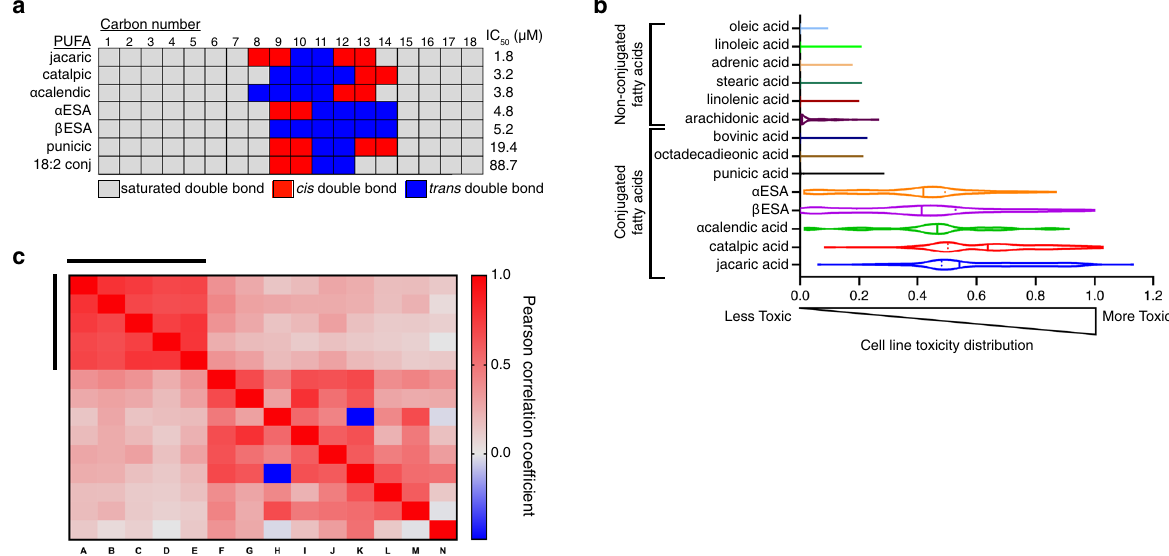
Fig. 3 Conjugated linolenic fatty acids are generally toxic to diverse cancer cells. a Schematic representing the location and double bond geometry of 18- carbon conjugated polyunsaturated fatty acids. Cell viability IC 50 values are shown for each conjugated PUFA from at least two biological replicate measurements in MDA-MB-231 cells after 72 h of treatment. b Assessment of fatty acid toxicity across cancer cell lines. A mixture of 100 barcoded human cancer cell lines were treated in triplicate with the indicated fatty acid at doses from 0 – 35 µ M. Viable cells of each cell line in the mixture were quanti fi ed at 48 h of treatment. A violin plot illustrates the distribution of cell line-speci fi c toxicities (calculated as the area over the dose dependent-cell viability curve across the treatment dose range). A toxicity value of 1 denotes complete loss of viable cells and 0 corresponds to viability similar to vehicle-treated controls. Dark bars denote median toxicity against all cell lines in the panel and dotted lines indicate quartile boundaries. c Heatmap presenting the Pearson correlation coef fi cients of the activity areas across the cancer cell line panel in b for each pair of fatty acids in the test set of fourteen. Red shows positive correlation and blue indicates negative correlation. The bars denote the position of the following conjugated linolenic acids from left to right and top to bottom: jacaric acid, catalpic acid, α -calendic acid, β ESA, and α ESA. Source data are provided as a Source Data fi